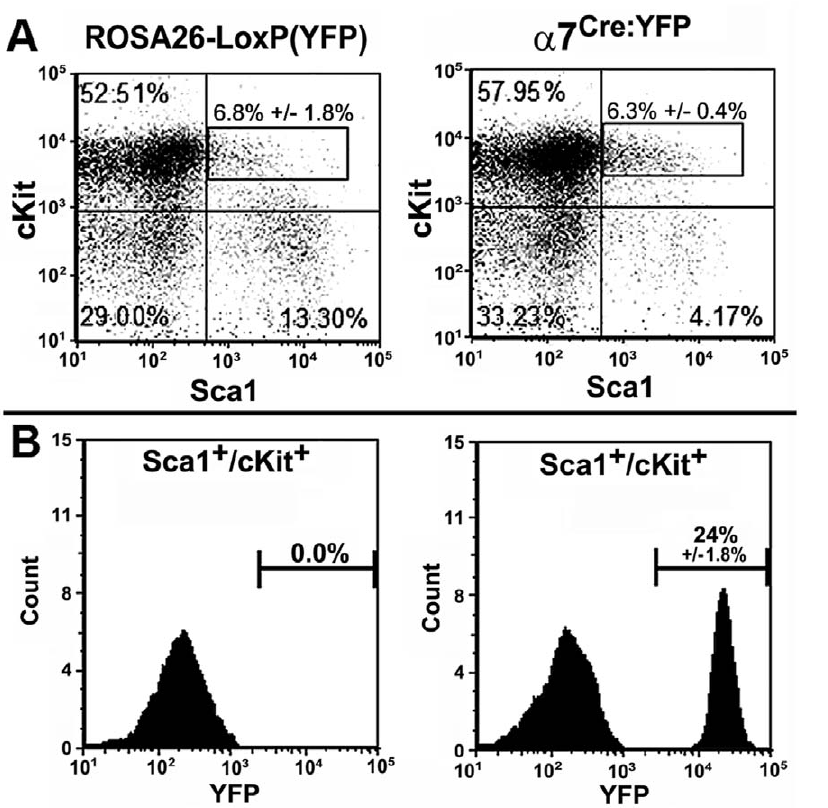
Figure 3. Lineage marker depleted cKit + Sca1 + a 7 lin + cells are a sub-population of cells identified in the bone marrow of a 7 Cre:YFP mice. Bone marrow cells from either Rosa26-LoxP(YFP) mice or a 7 Cre:YFP mice were isolated and depleted of cells committed to a developmental lineage such as myeloid cells (lineage positive cells, see Methods). A) Approximately 6% of the lineage depleted bone marrow cells (boxed) were cKit + /Sca1 + regardless of their a 7 expression background. B) Gating on the boxed cKit + /Sca1 + cells and measuring the a 7 lin + or a 7 lin– cells (FL1/YFP) revealed the absence of a 7 lin + cells in the Rosa26-LoxP(YFP) control mice, but approximately 24% of the lineage depleted, cKit + /Sca1 + cells from the a 7 Cre:YFP mice were a 7 lin + . The percent a 7 lin + (YFP) positive cells in the bone marrow cells were approximately 18% prior to lineage depletion (not shown). The results shown here represent the averaged data (6.3%) and the standard error of the mean (0.4%) from N=7 mice.